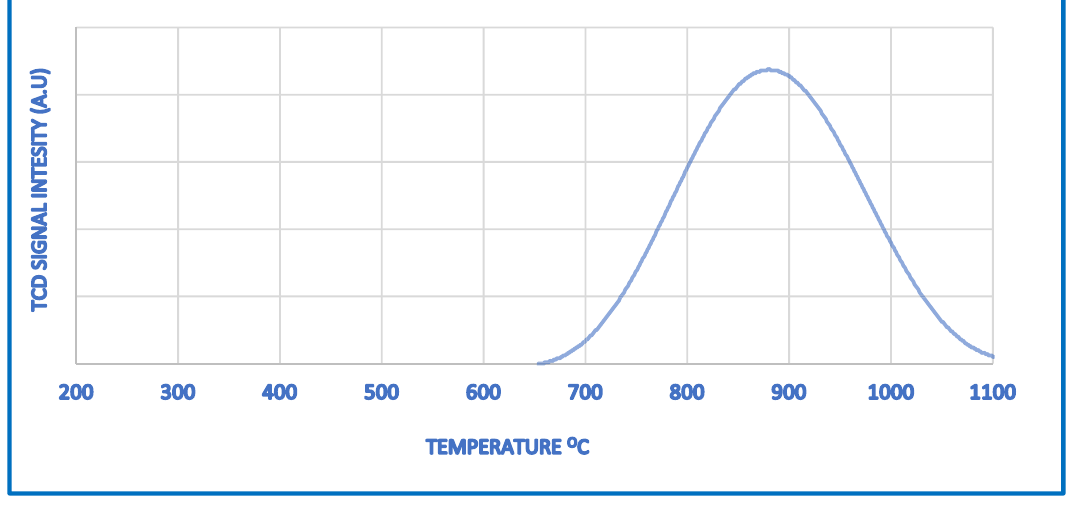
Figure 10. NH 3 -TPD of CoAl 2 O 3